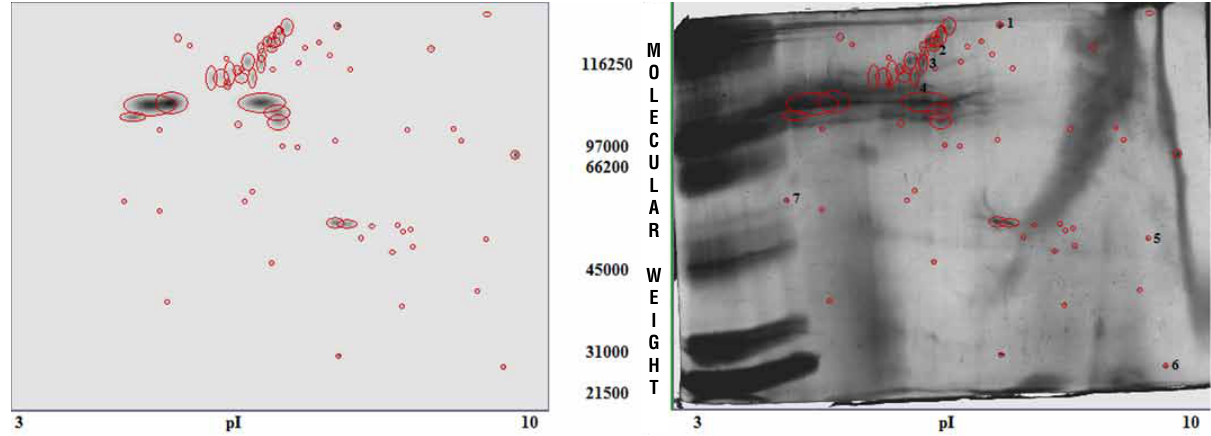
Figure 3 - 2D page of >3kDa proteins from human renal CaOx